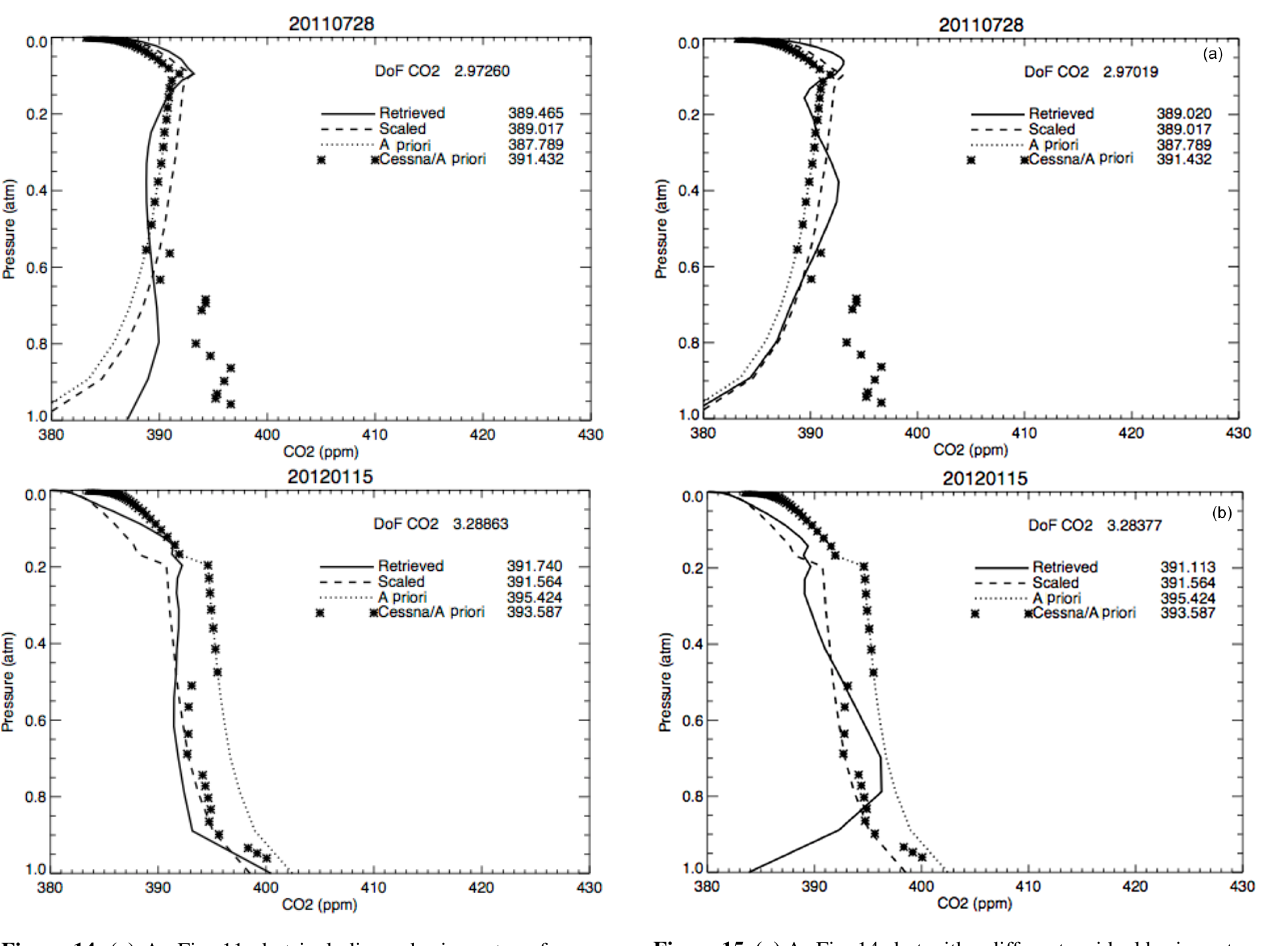
Figure 14. (a) As Fig. 11a but including a basis vector of mean residuals in the forward model. (b) As (a) but for 15 January 2012.